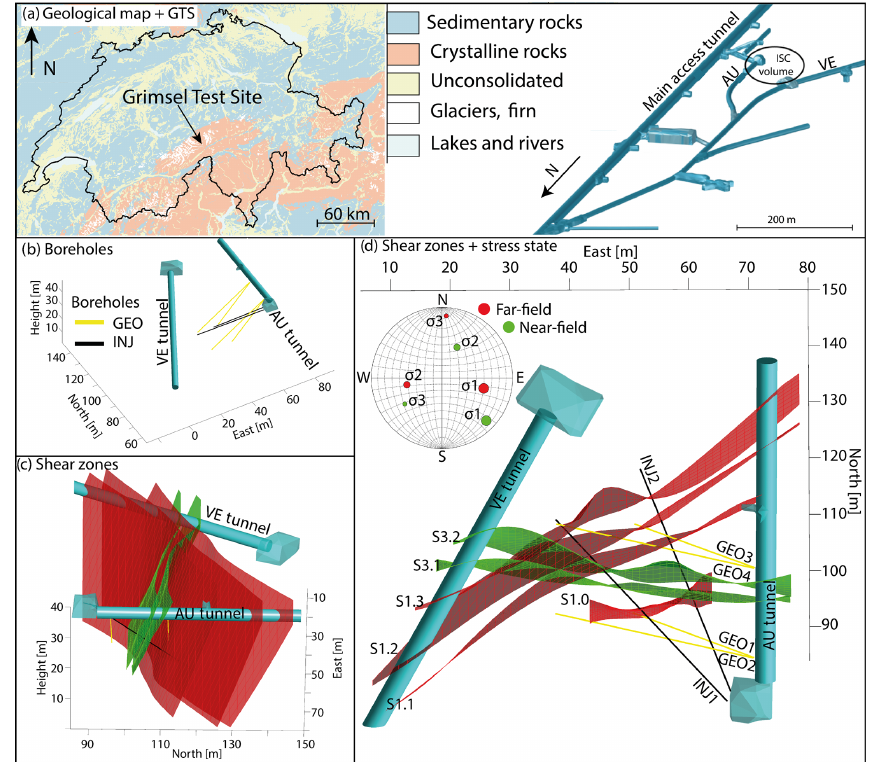
Figure 1. Location of GTS within Switzerland along with an overview of GTS (a) and ISC test volume with drilled boreholes (b) . The geologically interpolated shear zones are visualized in panels (c) and (d) . Panel (c) looks towards the west with an inclination of ∼ 30 ◦ . The orientations of the principal stress components for the perturbed (near-field) and unperturbed (far-field) stress fields are plotted in a lower hemisphere stereo net (d)